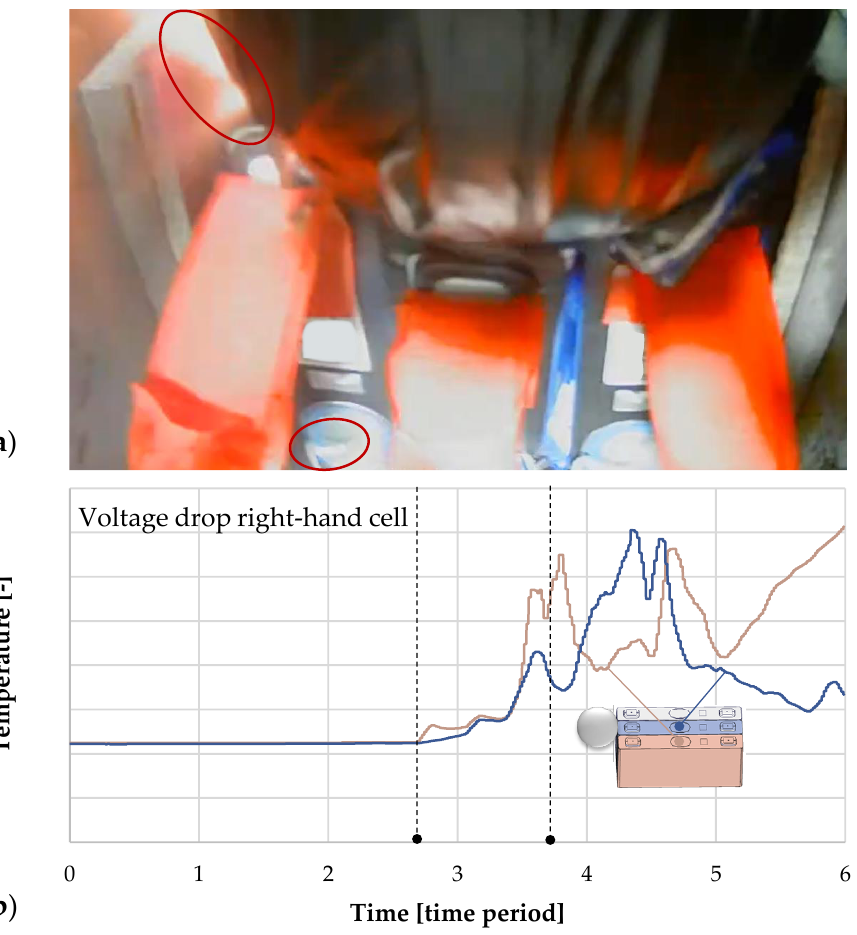
Figure 8. ( a ) V-direction with hemispherical impactor at event; ( b ) temperature over time for sensor at vent.